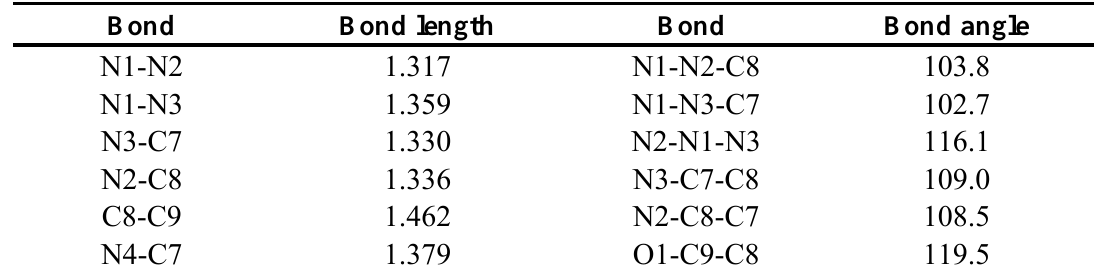
Table 2. Selected bond lengths and bond angles for 23